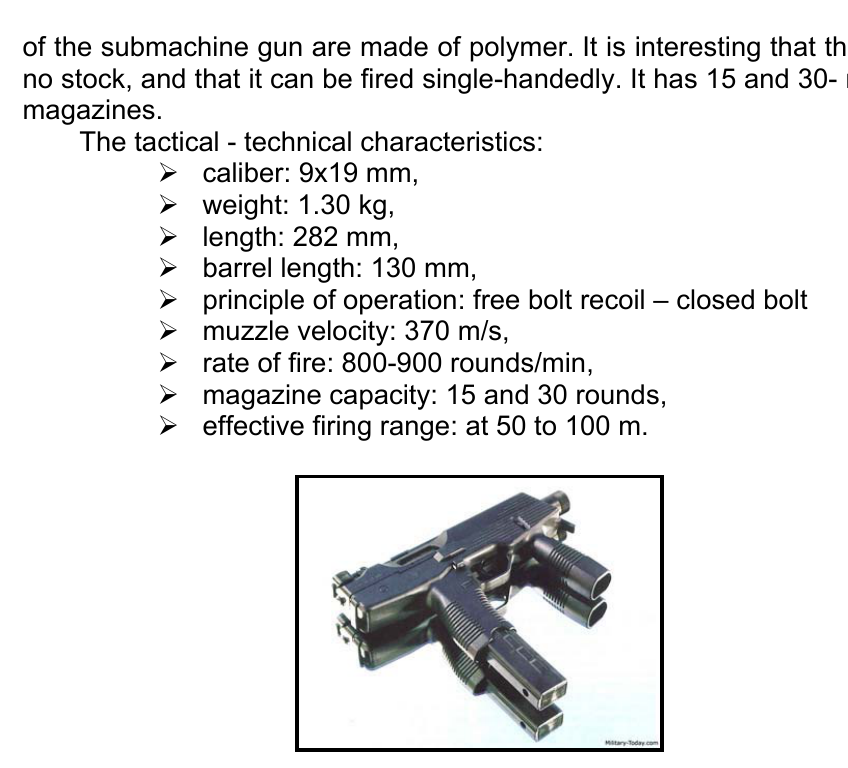
Figure 7 – Steyr TMP Submachine gun Рис . 7 – Автомат Steyr TM П Слика 7 – Аутомат Steyr